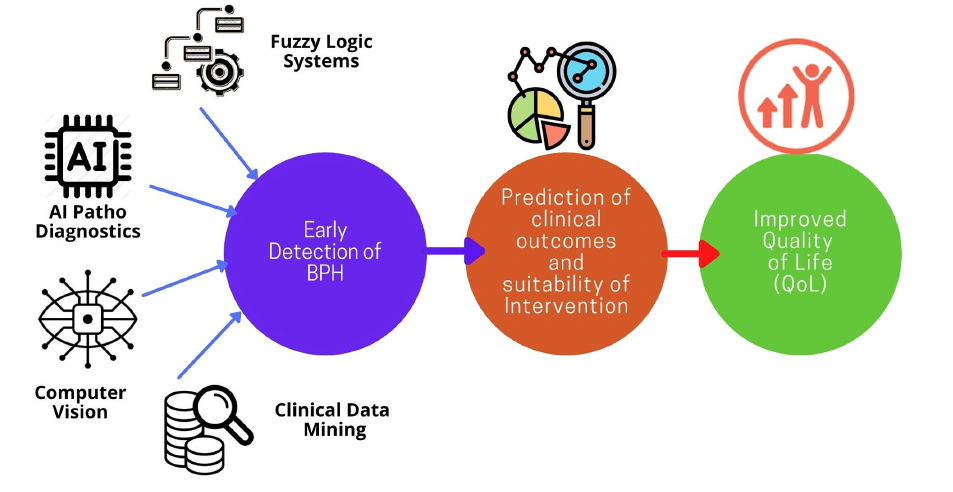
Figure 1. Current applications of artificial intelligence in benign prostatic hyperplasia